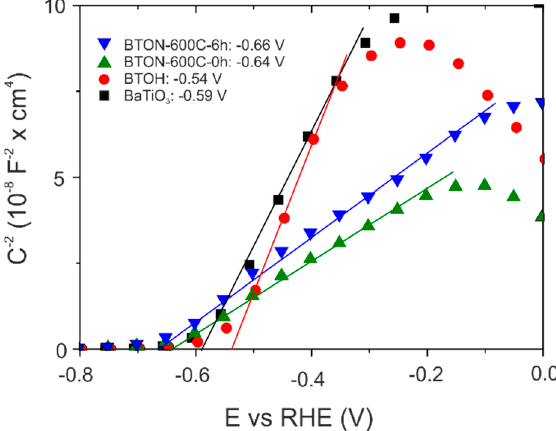
Figure 9. Mott–Schottky plots of BaTiO 3 , BTOH, BTON-600C-0 h, and BTON-600C-6 h. Table 3. Compilation of bandgaps and flat band potentials.